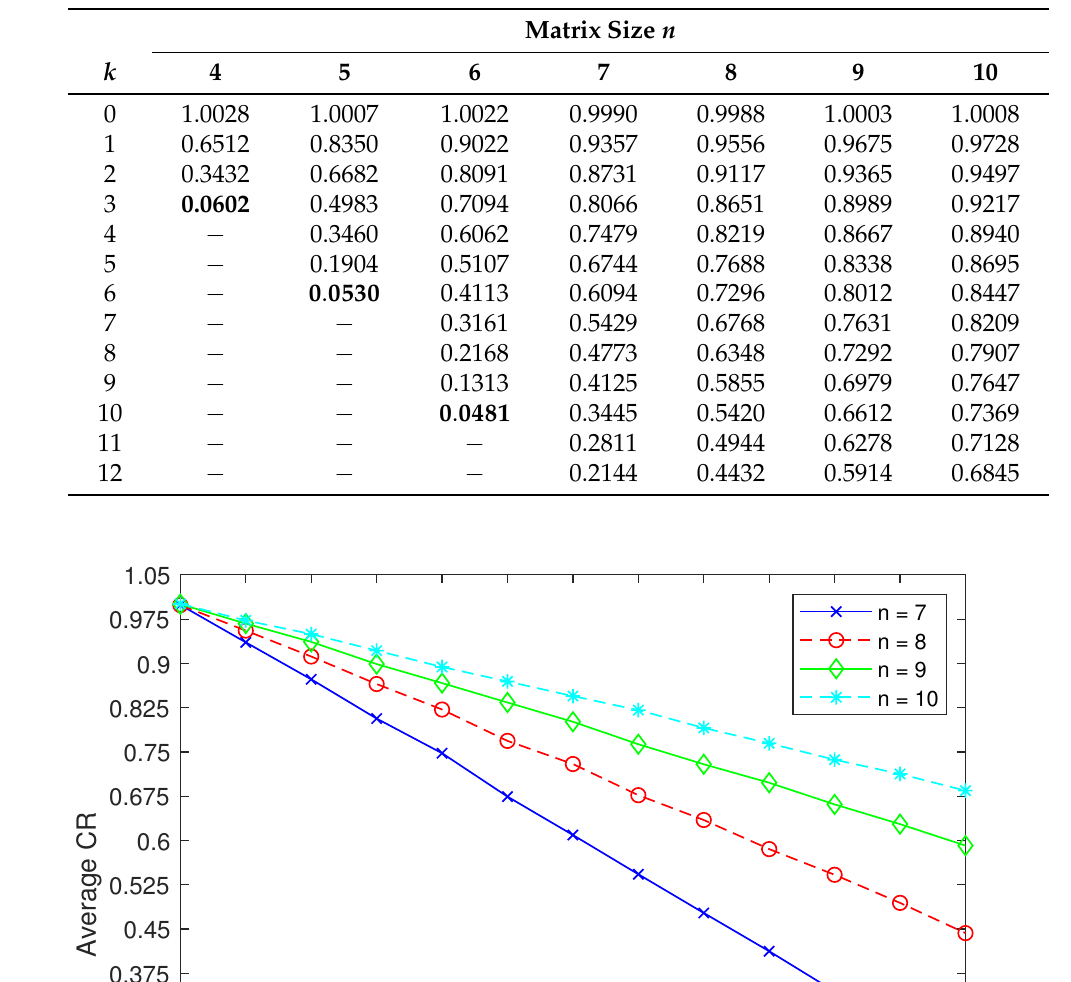
Table 4. Average CR of 10,000 random matrices from the Saaty scale.